Question: Summarize what this figure shows in one sentence.
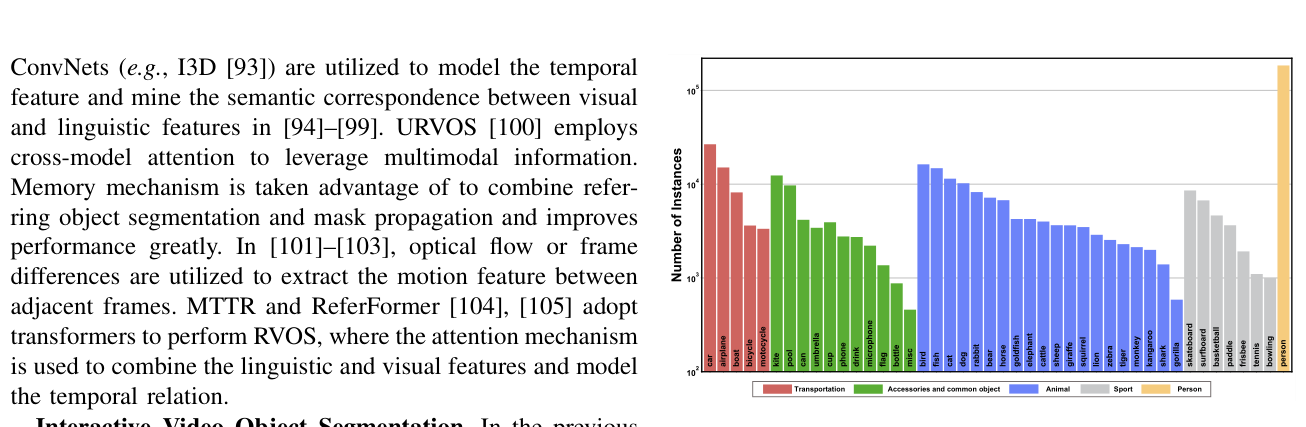
Answer: The histogram of instance masks for five parent classes and sub- classes. Objects are sorted by frequency. The entire category set roughly covers diverse objects and motions that occur in everyday scenarios.